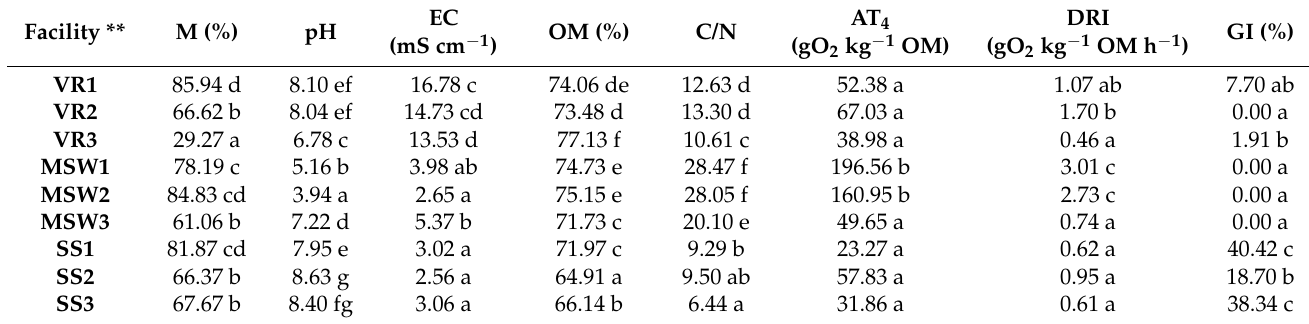
Table 2. Properties of raw materials from industrial composting facilities